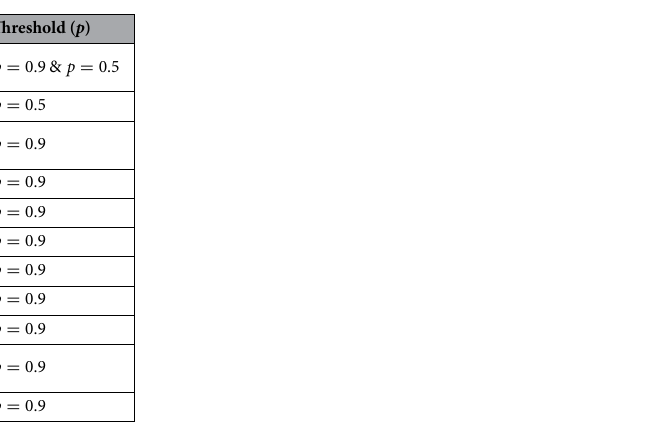
Table 5. List of features extracted for the purpose of predicting lymph node metastases type. Features were extracted after thresholding tumour probability heatmaps. For feature numbers 5, 6, 7, 8 and 9 the following statistics were computed- maximum, mean, variance, skewness, and